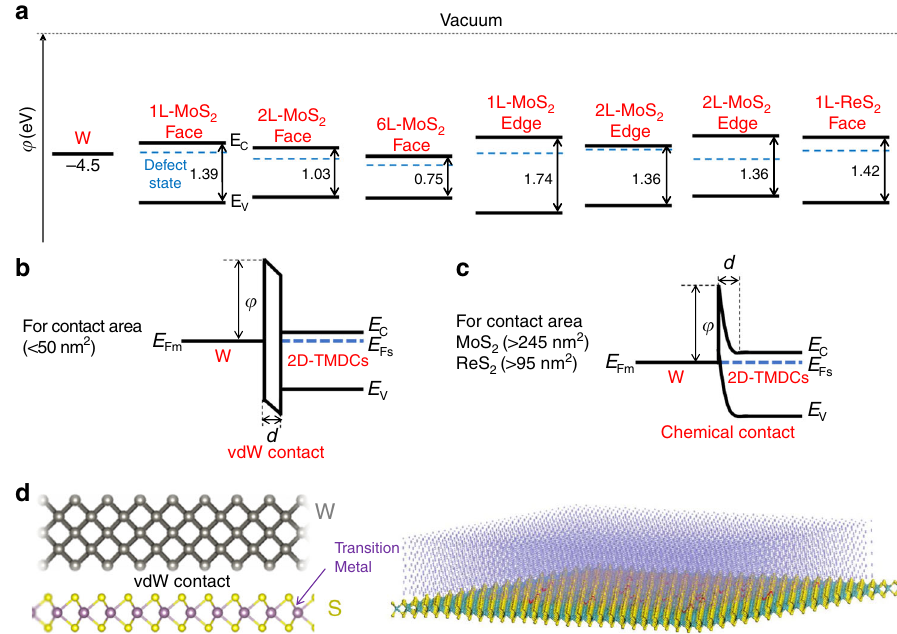
Fig. 3 Band formation of the W-to-TMDCs electrical contacts. a Band alignment before W-2D-TMDCs contact obtained by DFT calculation. b , c Band formation of 2D-TMDCs after W nanotip contacts with different area. Detailed information in Supplementary Table 1 and Supplementary Fig. 2. d Illustration of the contact area effect (left: small contact; right: large contact) to the W-2D-TMDCs.